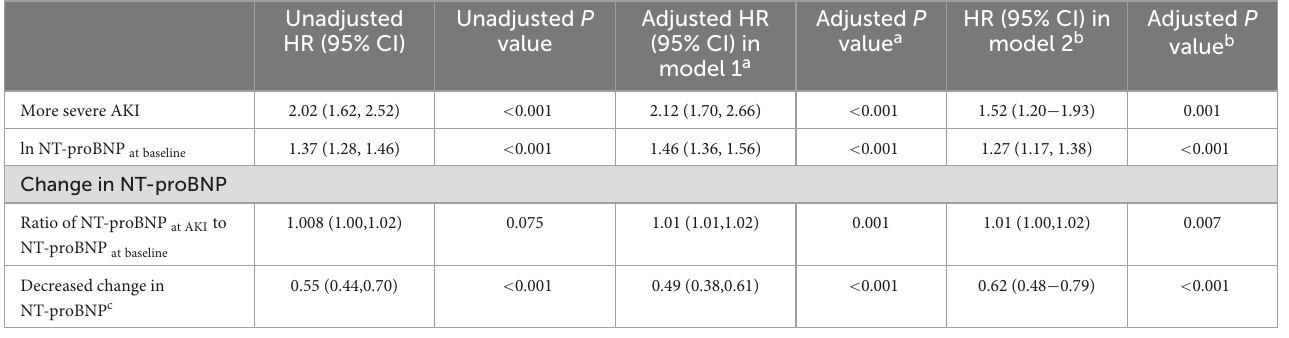
TABLE 2 Univariable and multivariable Cox regression analysis for 90-day mortality by AKI stages and NT-proBNP levels.